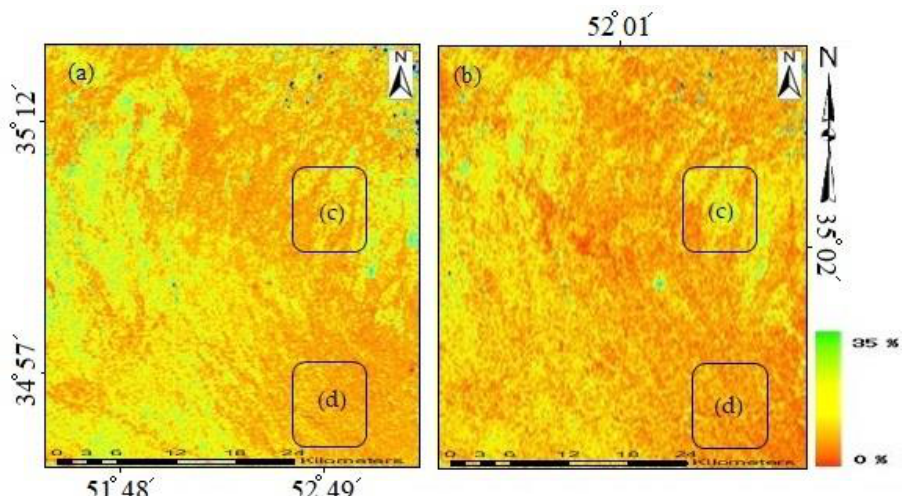
Figure 8. The volumetric soil moisture (Vol%) of the Dubois ( a ) and the Oh model ( b ) from 22 October 2010 and the rectangle (c,d) correspond to the same position of the Google Earth image in Figure 9.